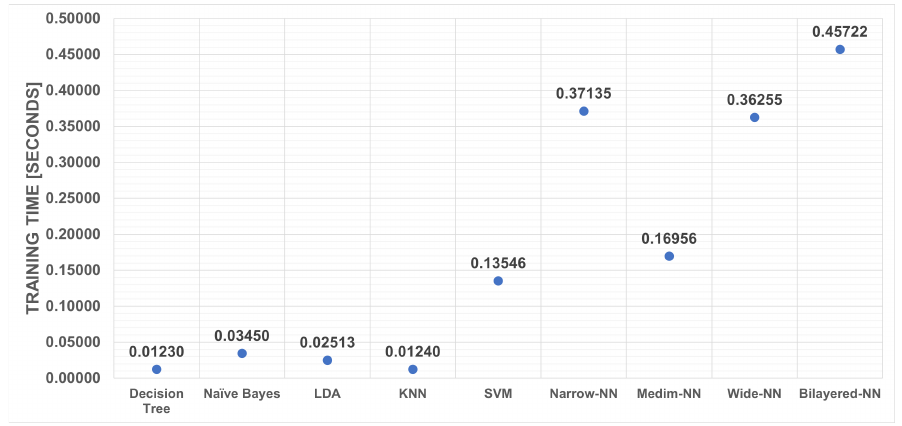
Figure 9. Training time of the nine ML